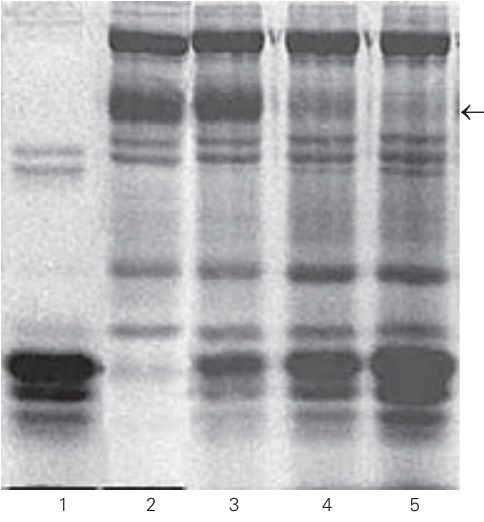
Figure 3. SDS-PAGE monitor- ing of the action of venom pro- tease inhibitors on the diges- tion of red blood cell ghosts from normal patients by spider venom. Lane 1 , normal ghosts not incubated with venom; lane 2 , normal ghosts with